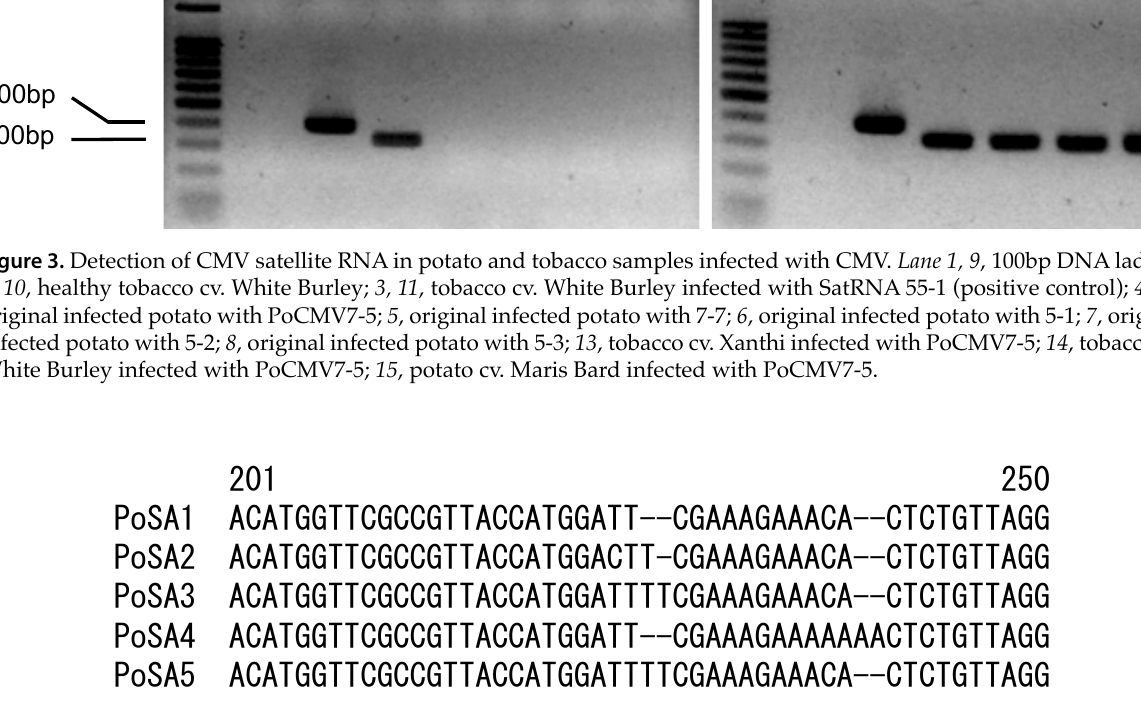
Figure 4. The hypervariable part of SatRNA variants detected with the Syrian potato CMV isolate PoCMV7-5. Numbers above indicate nucleotide positions; -, nucleotide